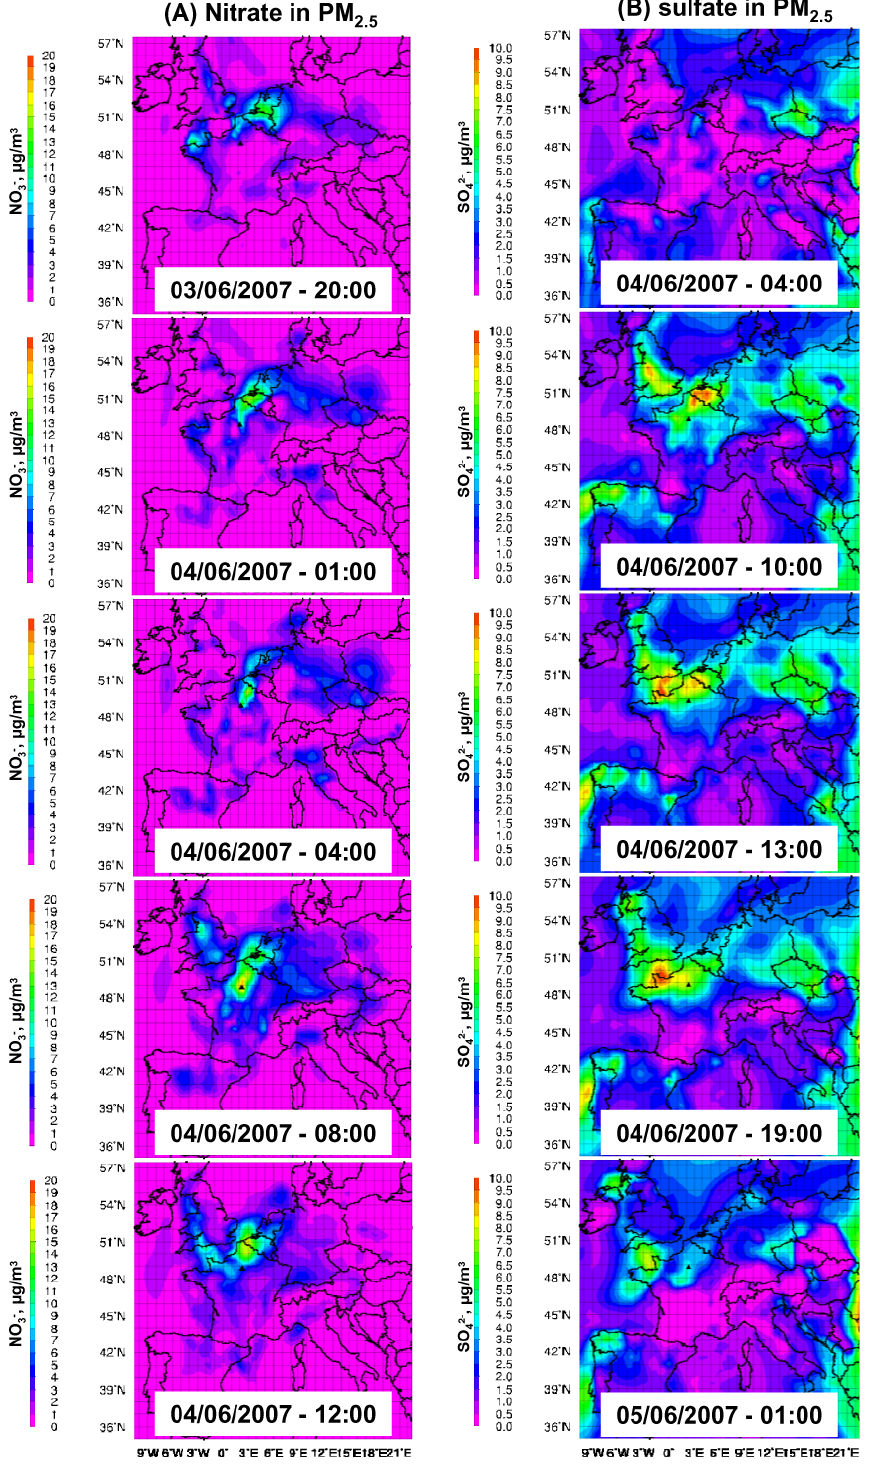
Fig. 8. Plume case study modeled by CHIMERE for fine nitrate (A) and fine sulfate (B) for the period 3–5 June